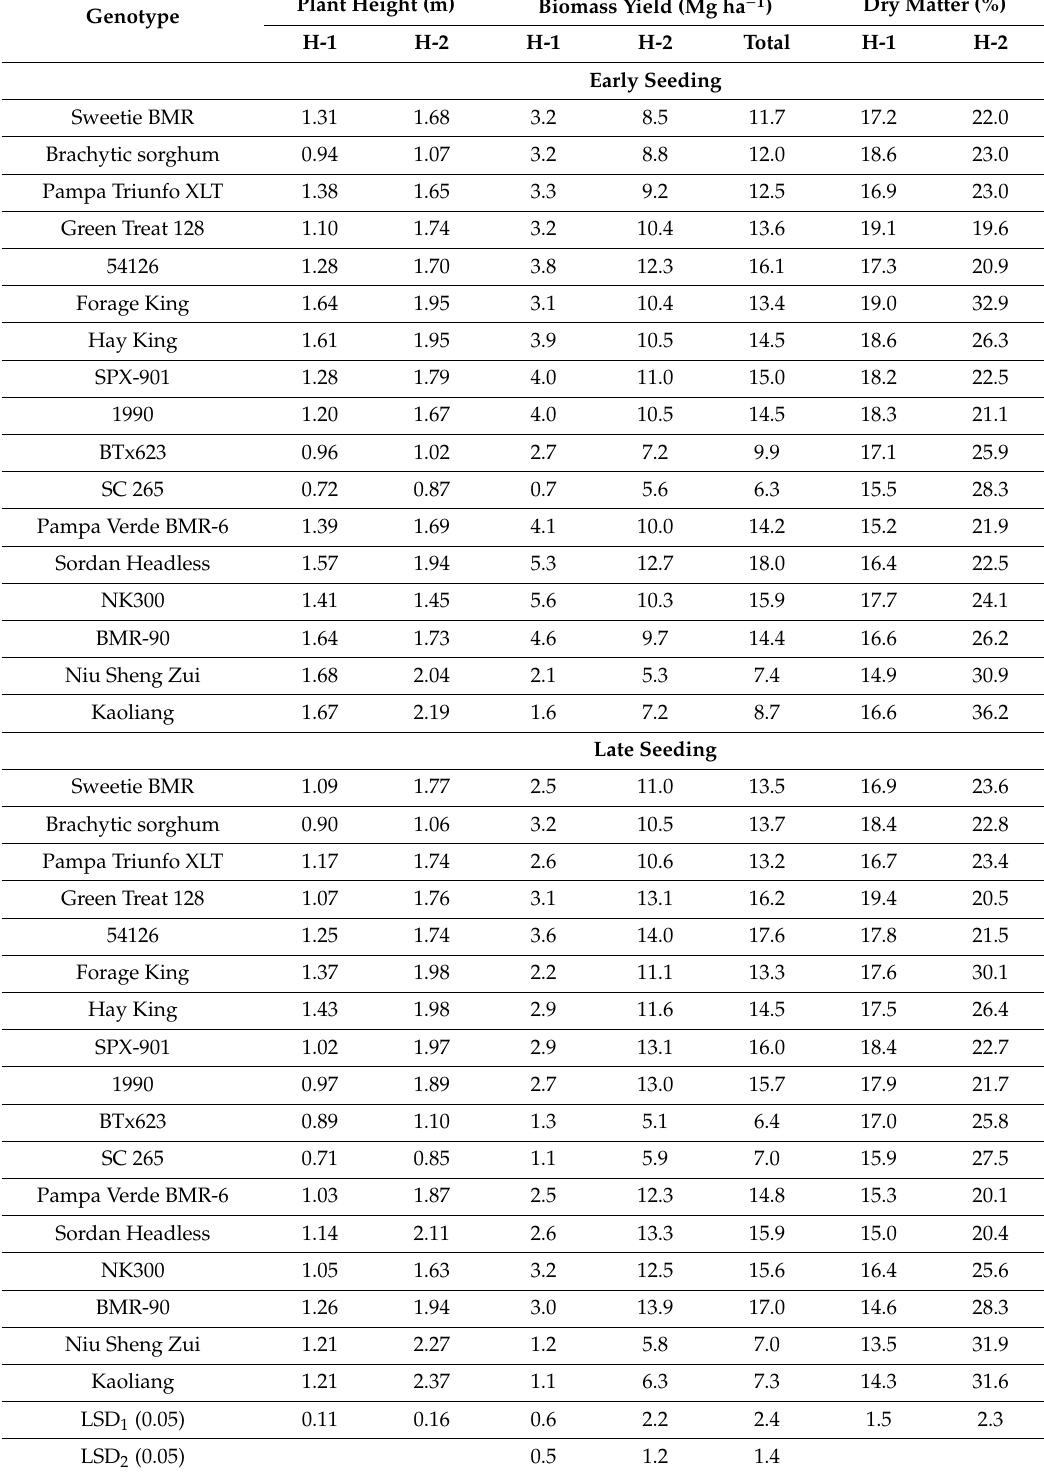
Table 3. Mean plant height, biomass yield and dry matter content of two harvests (H-1 and H-2) in forage sorghum genotypes seeded on two dates averaged across four environments, in Fargo and Hickson, ND, USA, in 2017 and